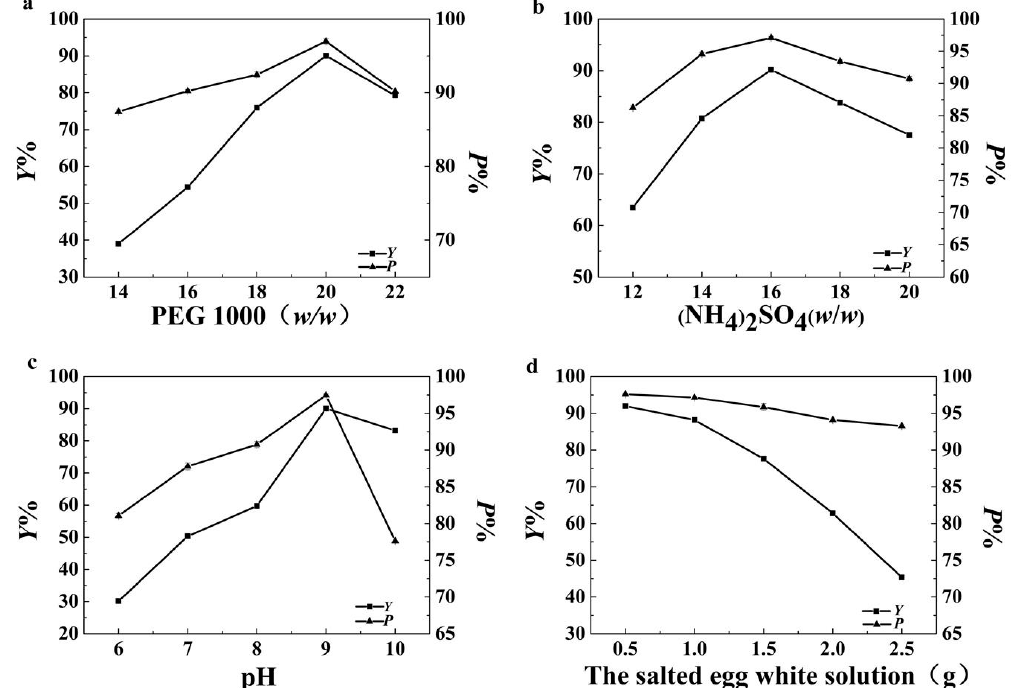
Figure 1. Comparison of single factor results. ( a ) Effect of the concentration of PEG 1000 on the extraction;( b ) effect of the concentration of (NH 4 ) 2 SO 4 on the extraction; ( c ) effect of pH on the extraction; ( d ) effect of the weight of the salted egg white solution on the extraction.